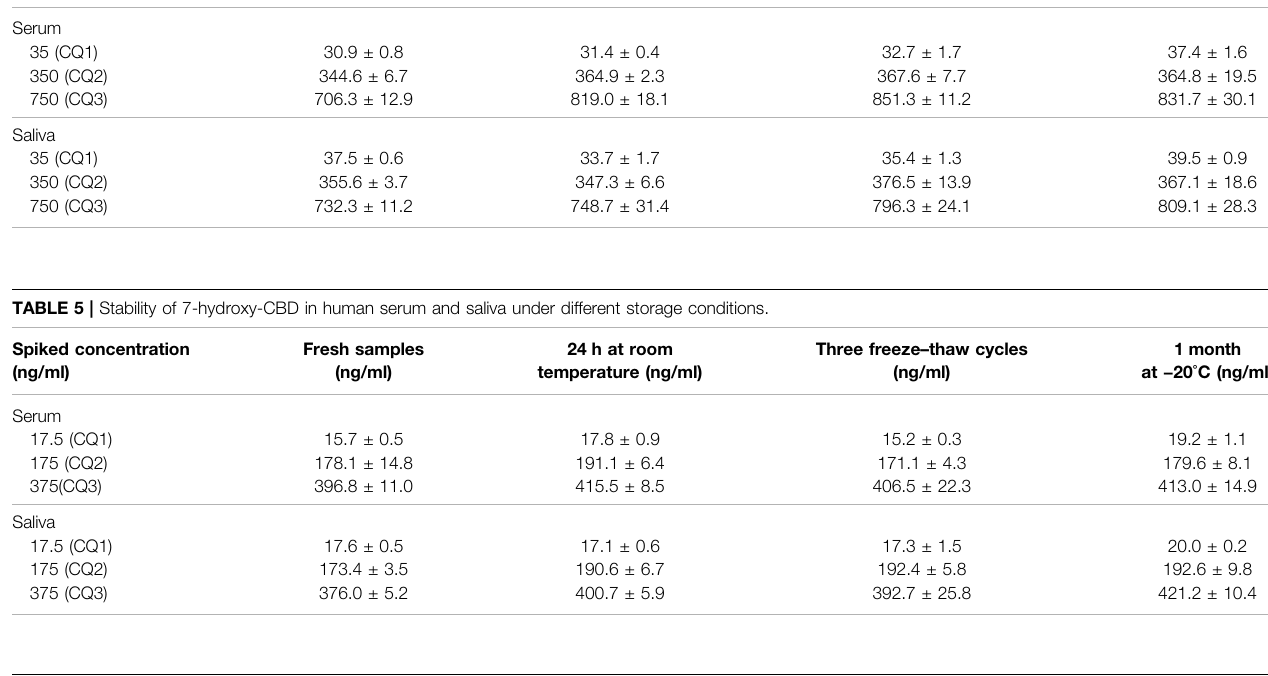
Fresh samples (ng/ml)